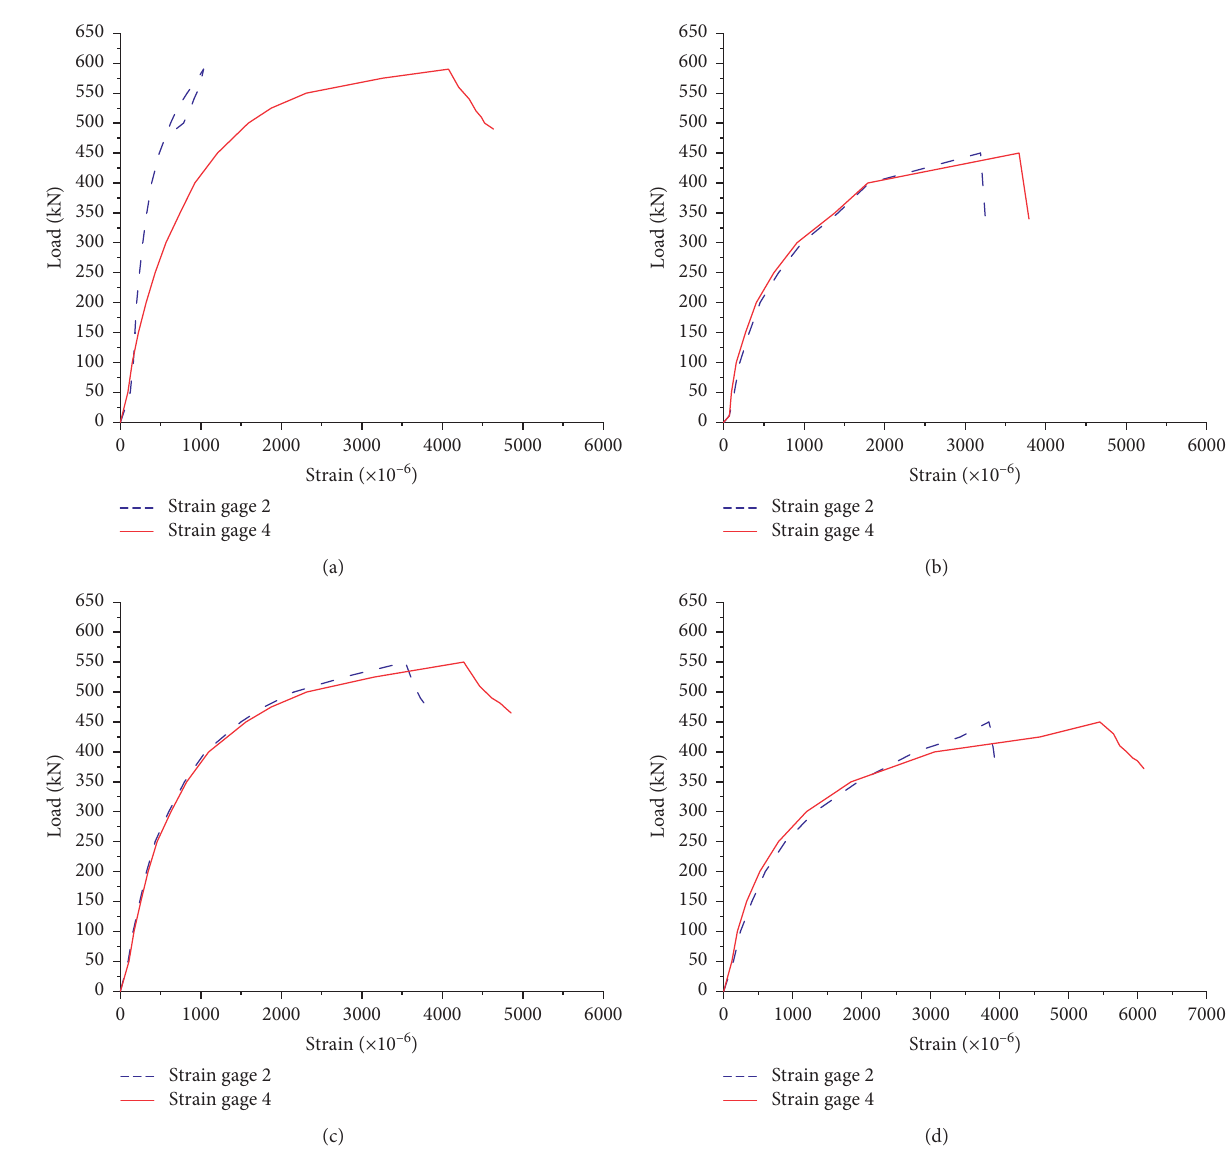
Figure 14: Load and strain curves of specimens: (a) GJ, (b) ZJA, (c) ZJB, and (d)